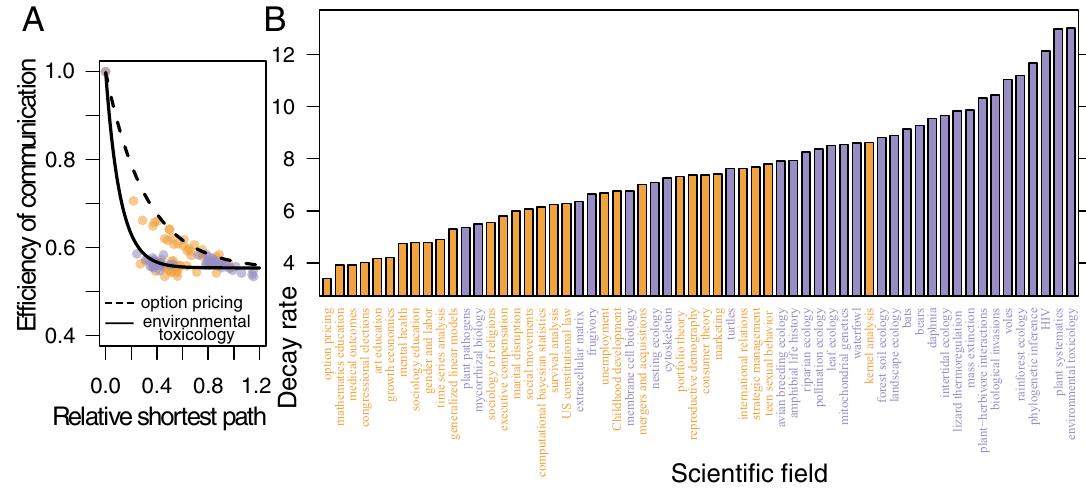
Figure 4: (A) Efficiency of communication from focal field i to target field j ( E ij = 1 − C ij ) decays with the distance to field j differently for different fields. Here we show the slowest decay (option pricing, dashed line) and the fastest decay (environmental toxicology, solid line) out of the 60 fields (see supporting information for others). (B) Decay rate γ plotted for behavioral science fields (orange) and biological science fields (blue). Focal fields with fast decay tend to have few fields nearby with which communication is efficient. Those with slow decay have several neighbors with relatively small cultural holes, that is, efficient communication. Distance is computed using the normalized shortest path: the average shortest path from a paper in field i to a paper in field j divided by the average shortest path from a paper in field i to another paper in field i . We subtract 1 from this value so that the normalized shortest path from a field to itself is 0 . This normalization allows us to account for differences in citation norms that cause focal fields to be tightly or loosely connected, that is, to have a short or long average path distance within